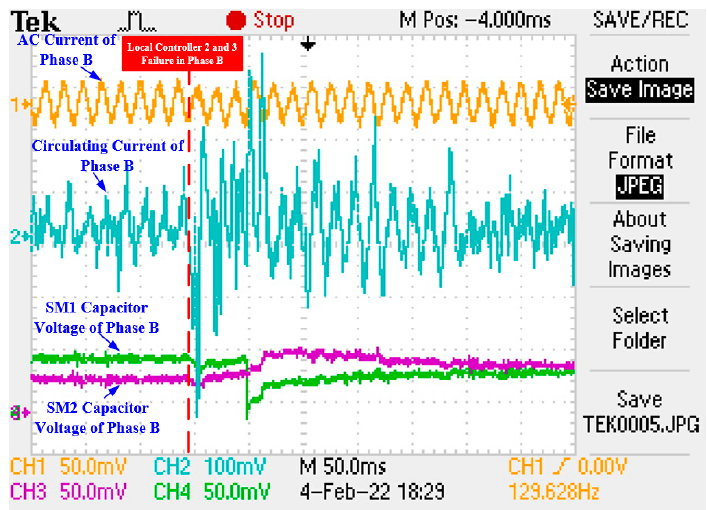
Figure 23. Result validation of Figure 19 with Opal-RT.